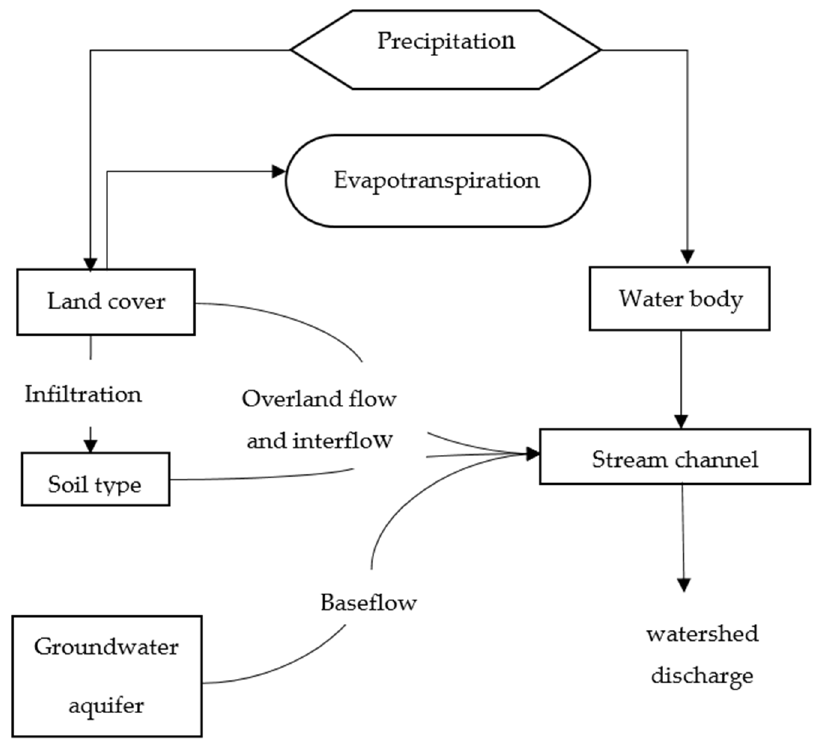
Figure 4. Flow chart of the steps of building a HEC-HMS model.